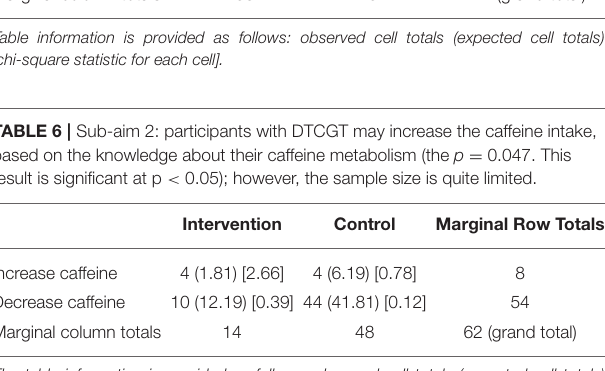
Table information is provided as follows: observed cell totals (expected cell totals) [chi-square statistic for each cell].